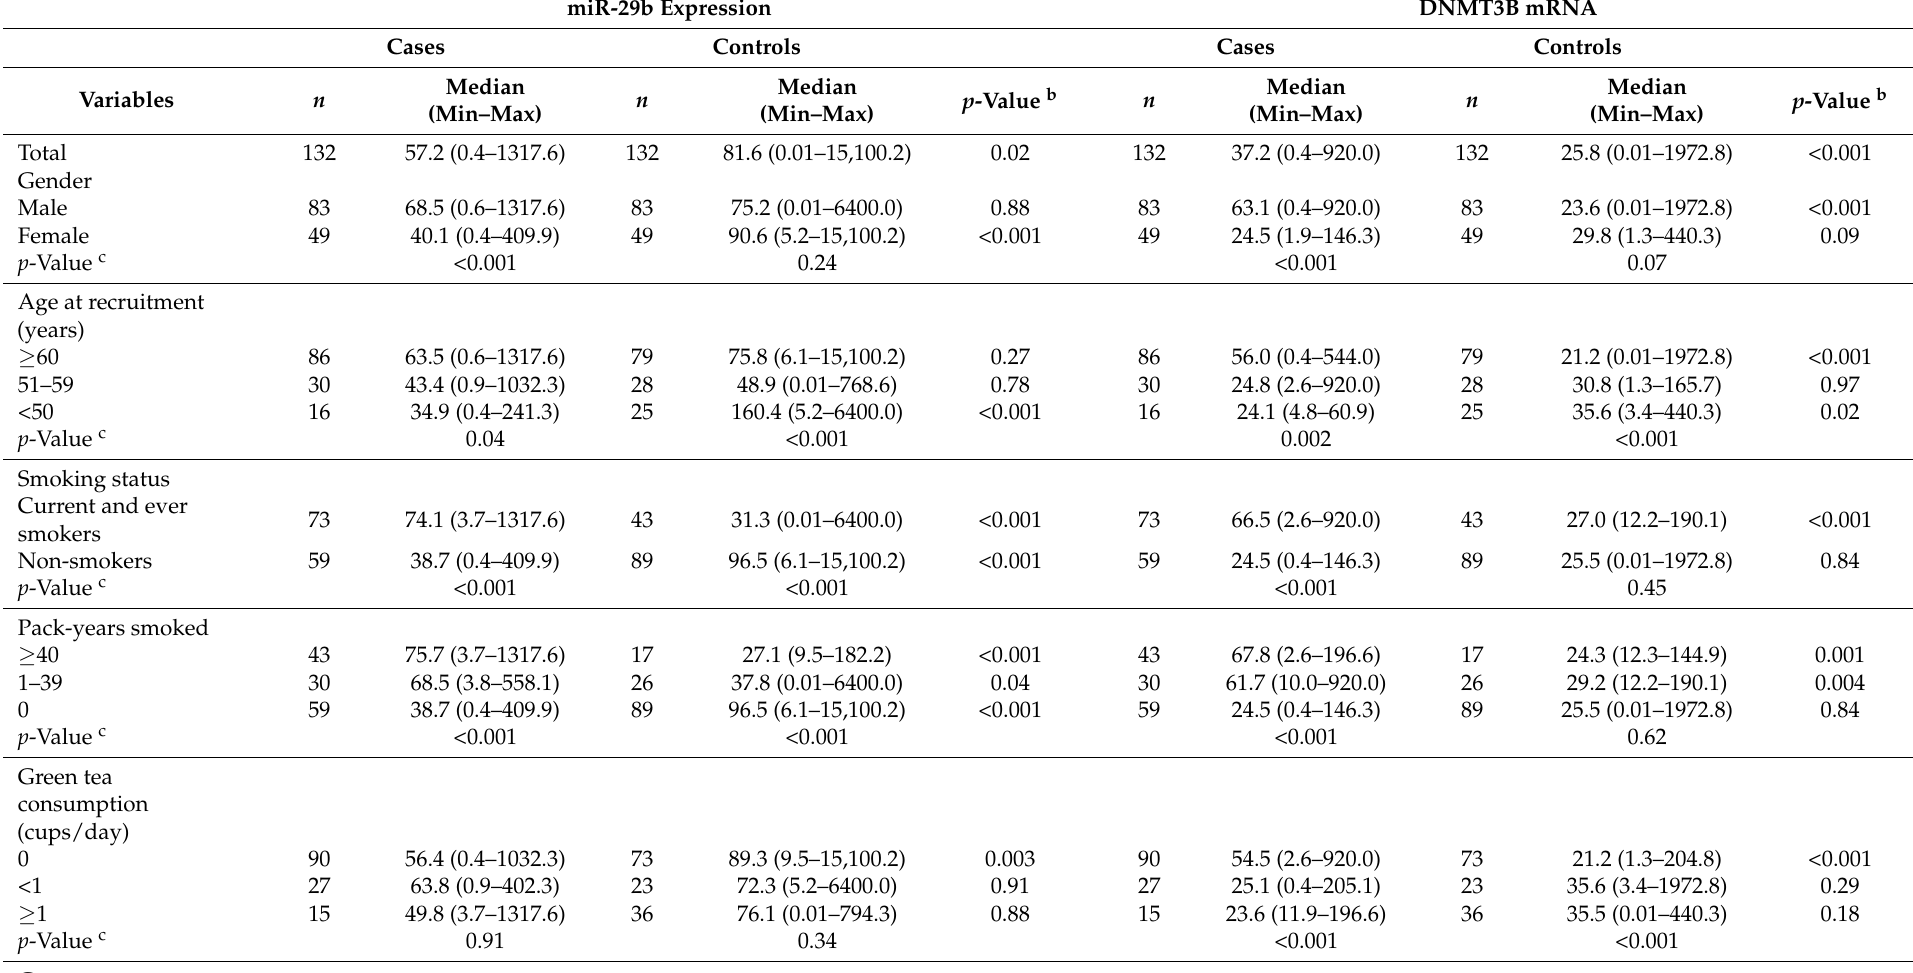
Table 2. Expression levels of miR-29b and DNMT3B mRNA in the groups of lung cancer patients and controls stratified by basic